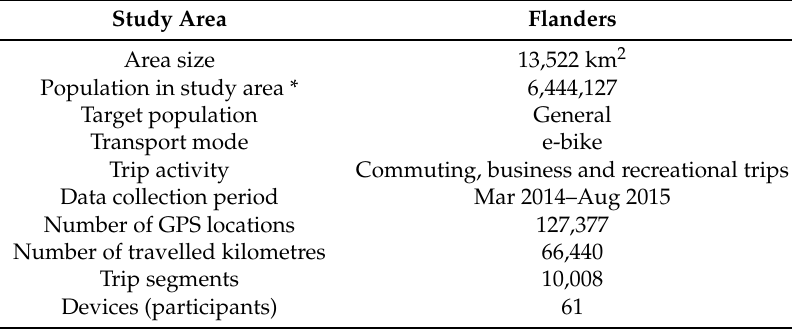
Table 1. Study area and target population.